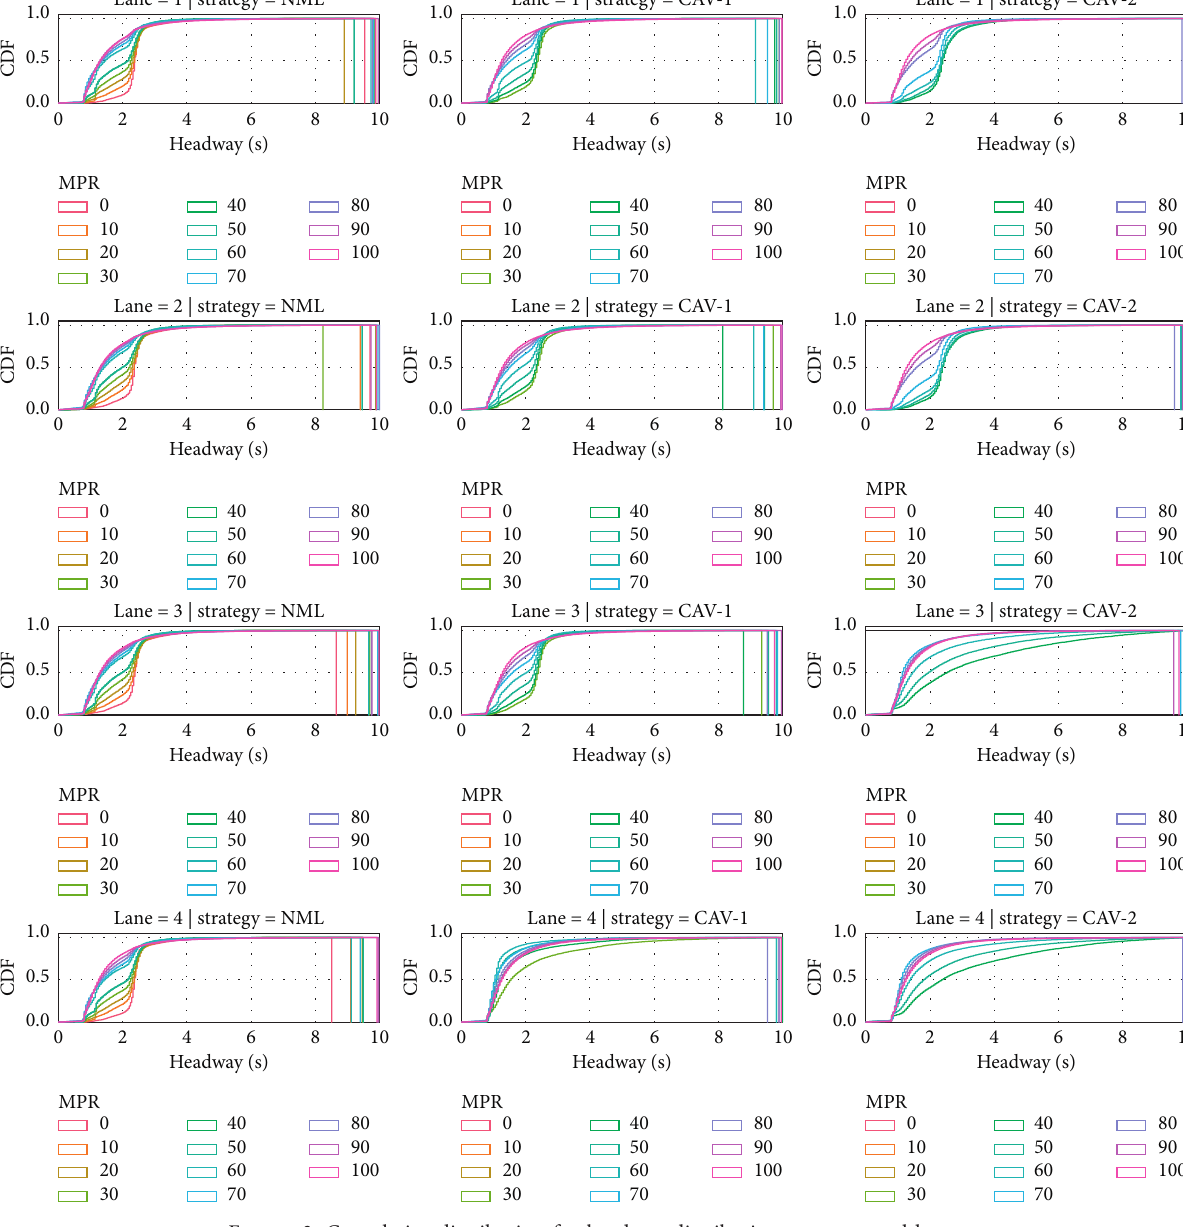
Figure 3: Cumulative distribution for headway distribution among travel